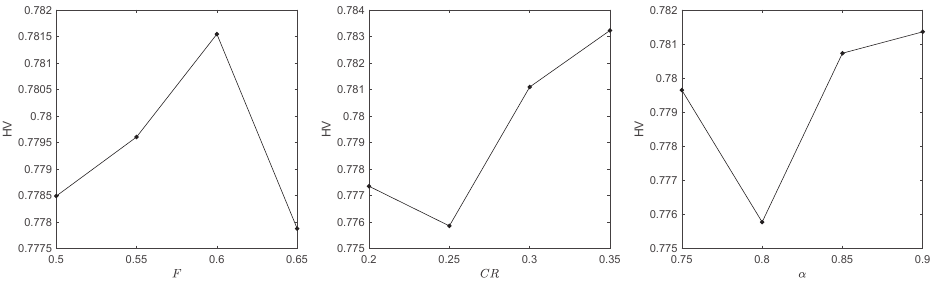
Figure 4. Main Effects Plot for F , CR and α